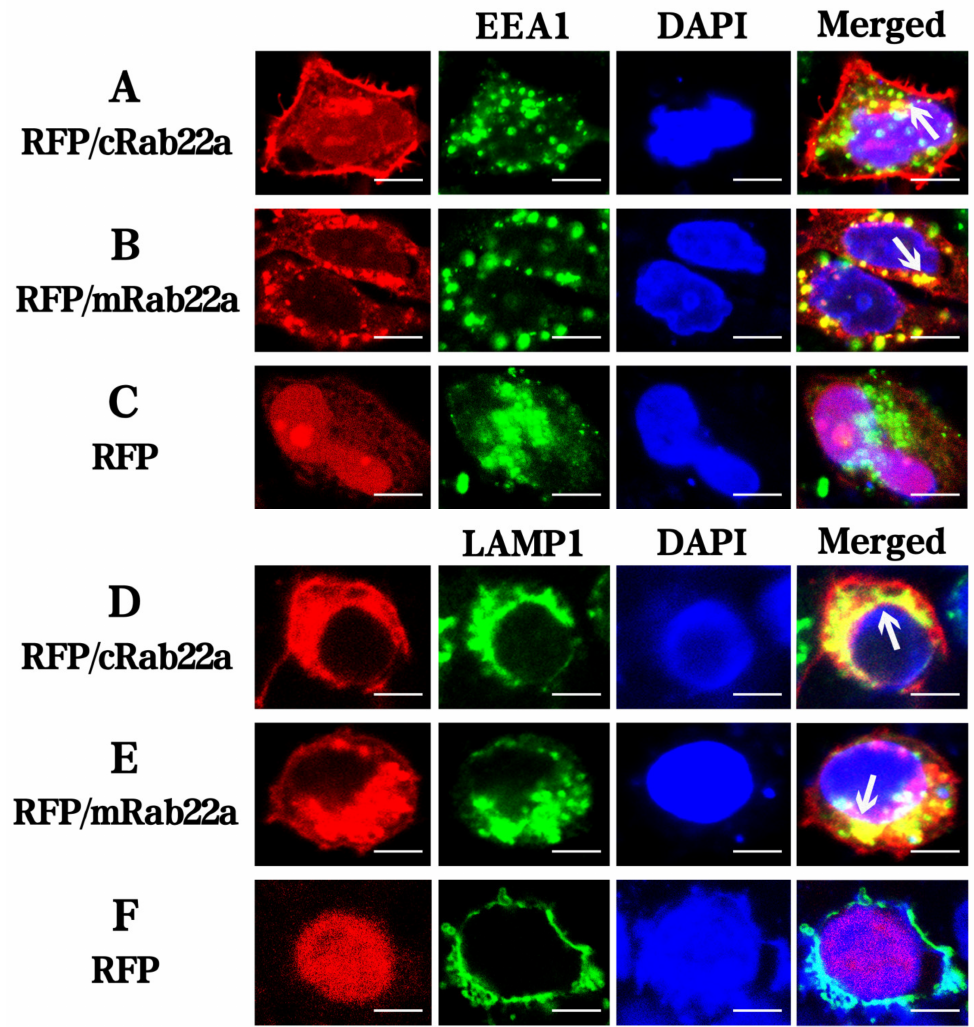
Figure 3. Co-localization of RFP/cRab22a and RFP/mRab22a with EEA1 and LAMP1 in eukaryotic cells (400 × ). The arrows indicate the co-localization of molecules (50 µ